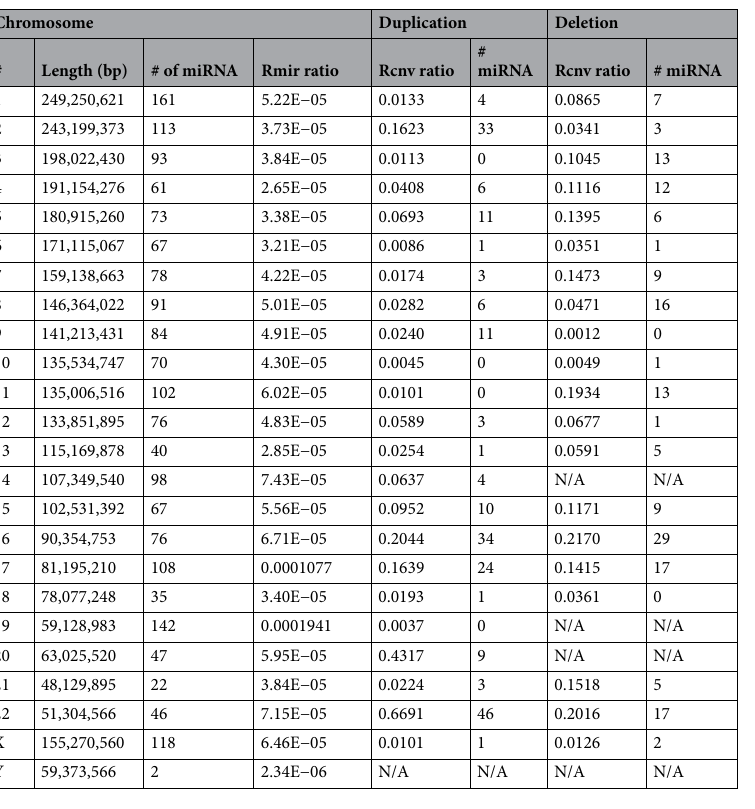
Table 4. Fractional lengths of precursor miRNA sequences and rare CNVs in CAKUT in relation to chromosome size. miRNA mapping has been performed on all key sources investigating CNV in CAKUT 4,10–14 ; Rmir ratio: the ratio between the sum of lengths of all miRNA precursor sequence lengths in a chromosome and the total length of the chromosome; Rcnv ratio: the ratio between the sum of lengths of all rare CNVs in a chromosome and the total length of the chromosome; # miRNA: for each chromosome, the total number of unique miRNA precursor sequences included in all rare CNVs detected in patients.